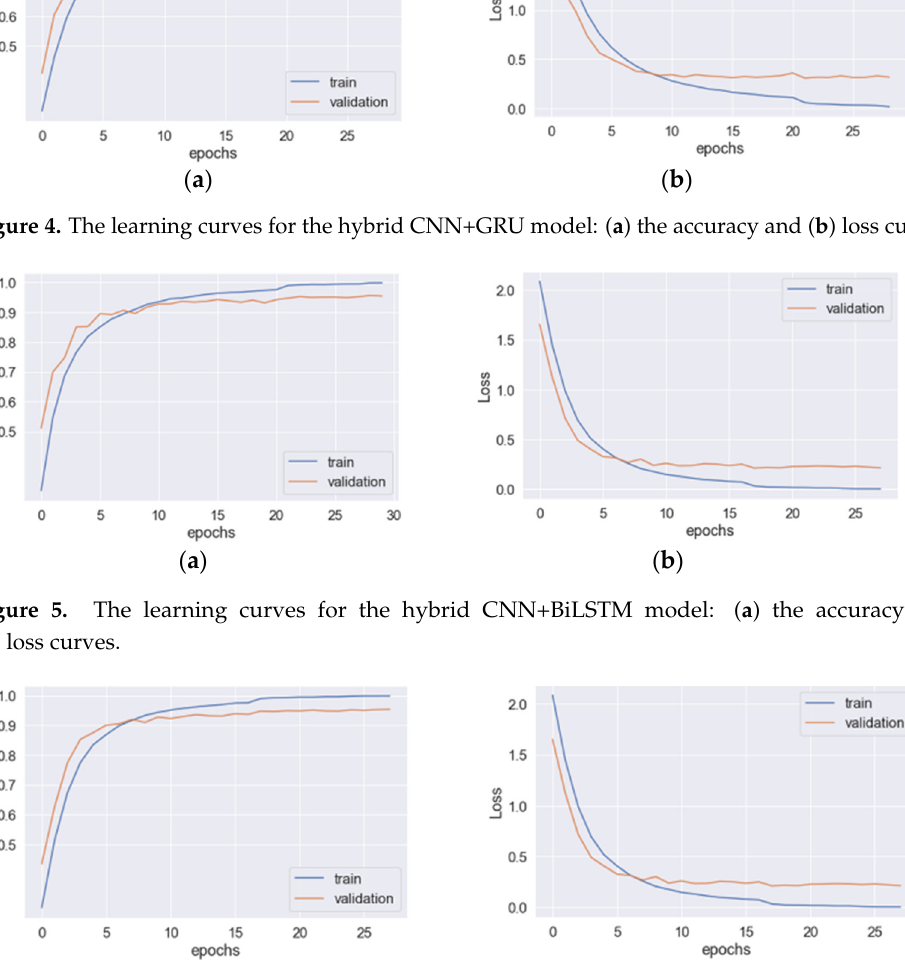
Figure 6. The learning curves for the hybrid CNN+BiGRU model: ( a ) the accuracy and ( b ) loss curves.